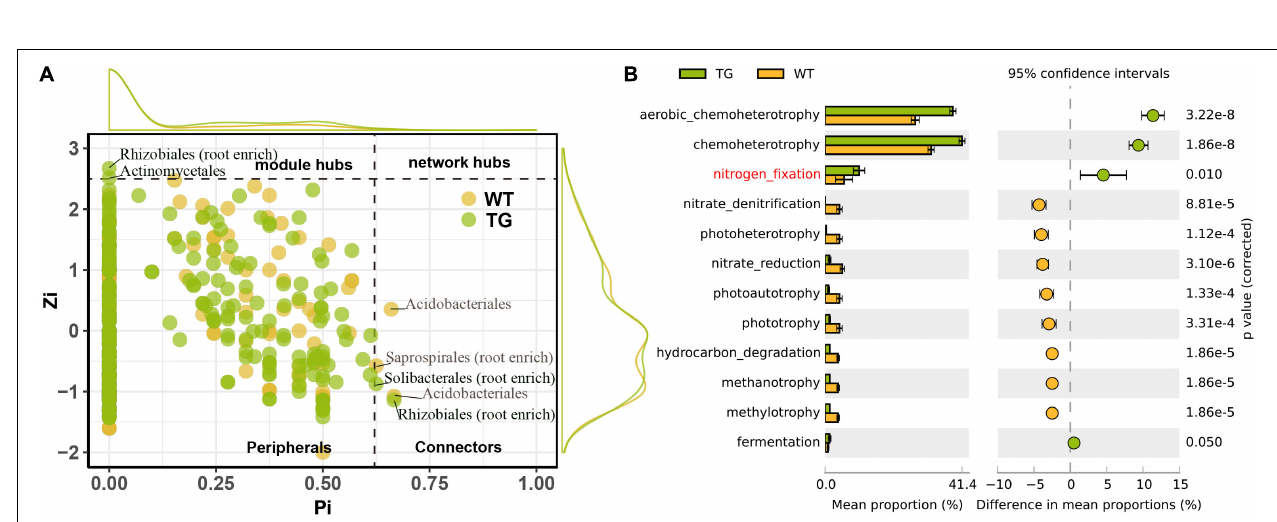
FIGURE 5 | (A) Network module separation and modularity calculation analysis shows dominantly functioning bacterial communities. Each dot represents an OUT in two sugarcanes. The x-Zi represents within-module connectivity and the y-Pi represents among-module connectivity. (B) Map prokaryotic clades to established metabolic or other ecologically relevant functions based on DESeq2 shows the ecological functions of root bacterial communities in TG and WT, indicating the enhanced ecological functions of TG root bacterial communities compared with WT.